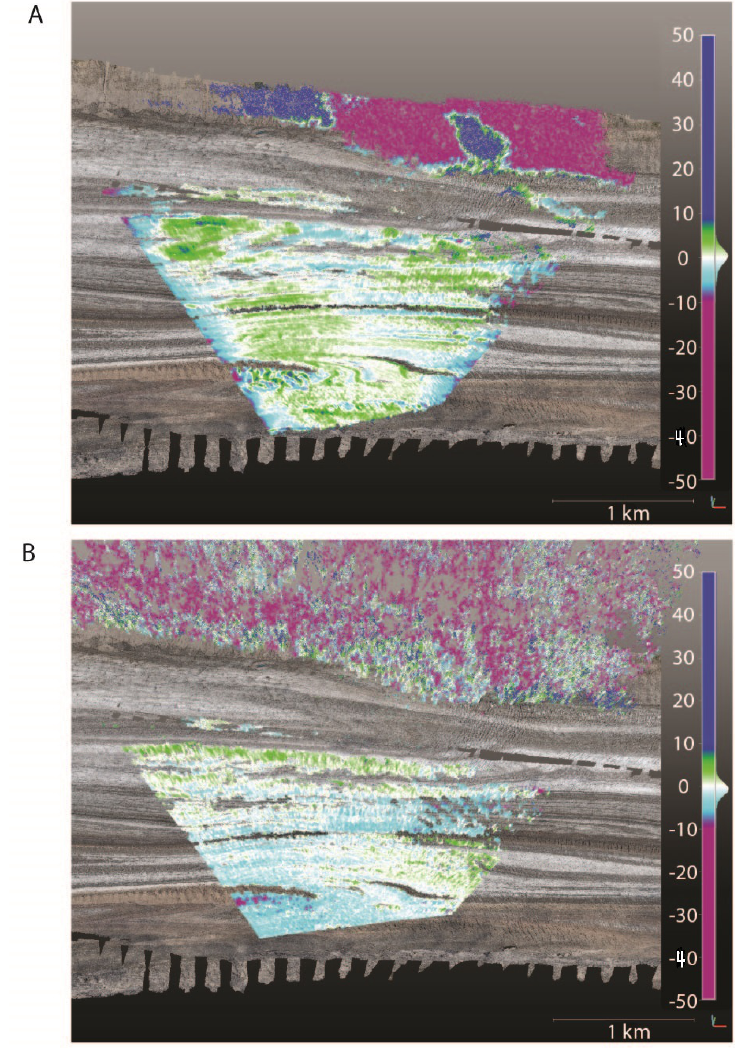
Figure 8. ( A ) The difference between the UPC and the RPC (27 July) for Nàłùdäy, after the UPC has been georeferenced. ( B ) The difference between the 24 July point cloud and the 25 July UPC, after georeferencing. White points in ( A , D ) show differences between − 1–1